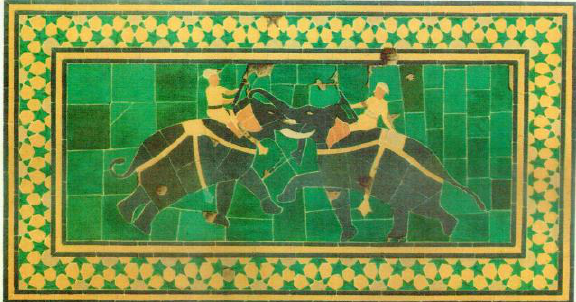
Figure 3. Plate. XI. Elephant Fight - Plate from Tile mosaic of the Lahore Fort by J.P Vogel